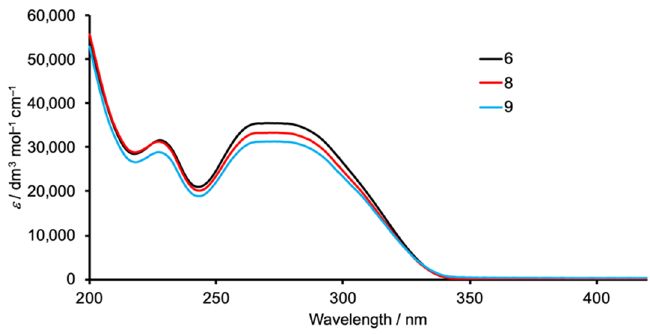
Figure 1. The solution absorption spectrum of compounds 6 , 8 and 9 (MeCN, see Table 2). Table 2. Absorption maxima in the solution UV-VIS spectra of 6 , 8 and 9 (MeCN, 5 × 10 − 5 mol · dm − 3 for 6 and 8 , 2 × 10 − 5 mol · dm − 3 for 9